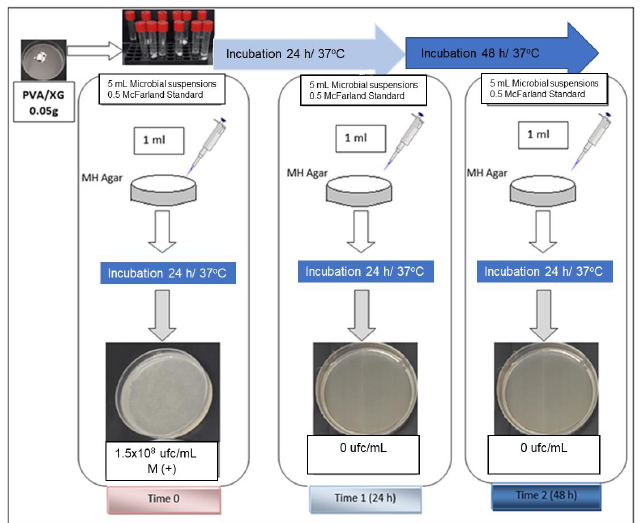
Figure 2. Working diagram for contact time (TC) technique: Time 0, Time 1 (24 h/37 o C), Time 2 (48 h/37 °C).